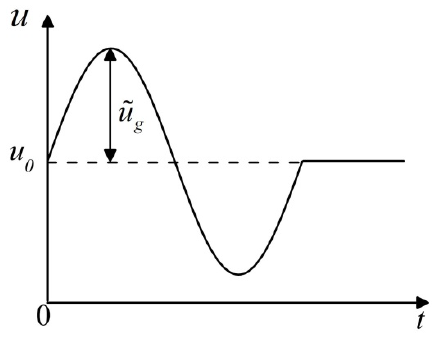
Figure 2. Definition of the gust velocity profile of interest in this study.